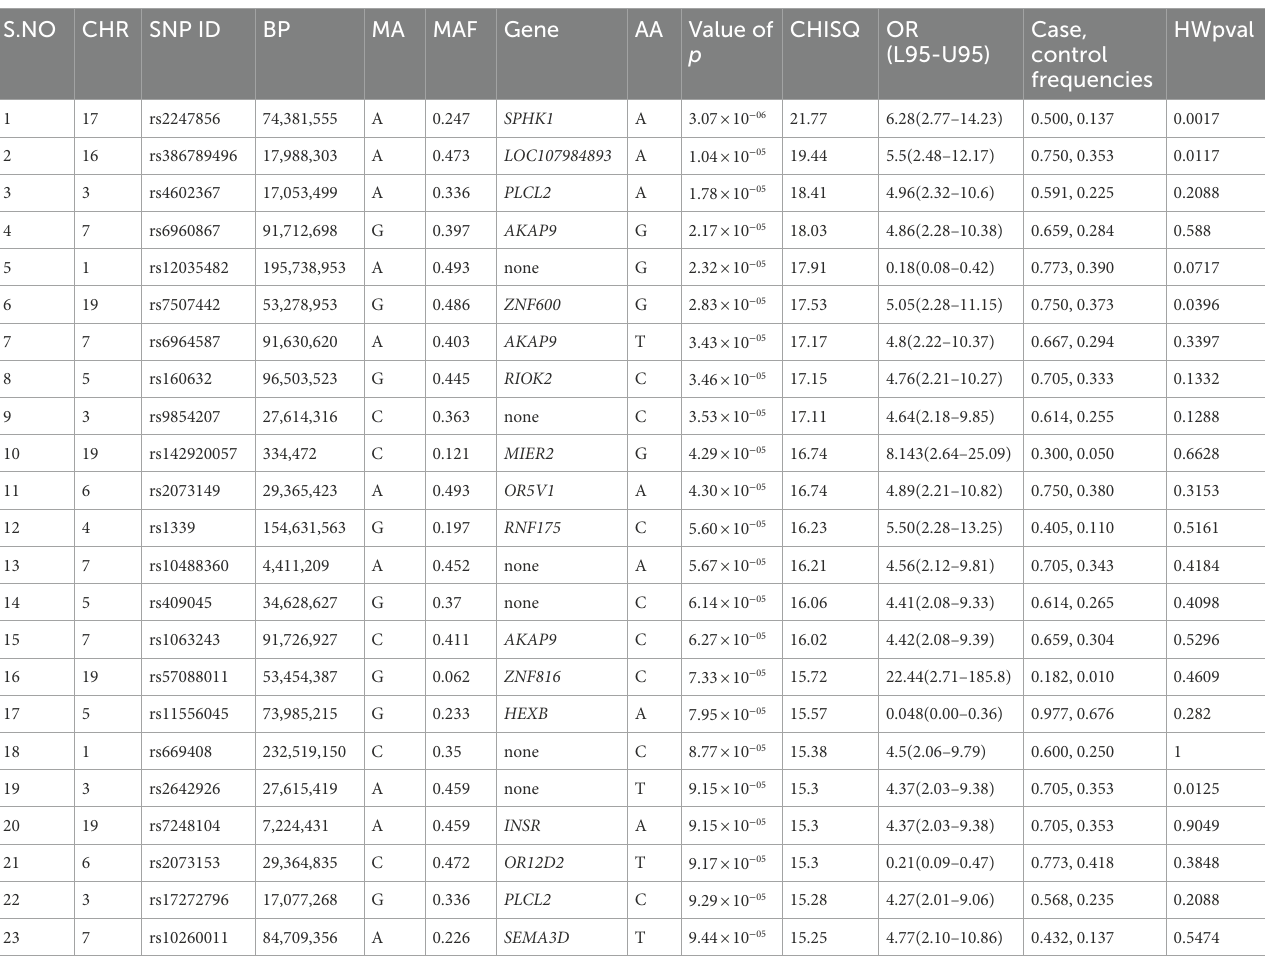
TABLE 2 The most significant SNPs associated with autism in Saudi